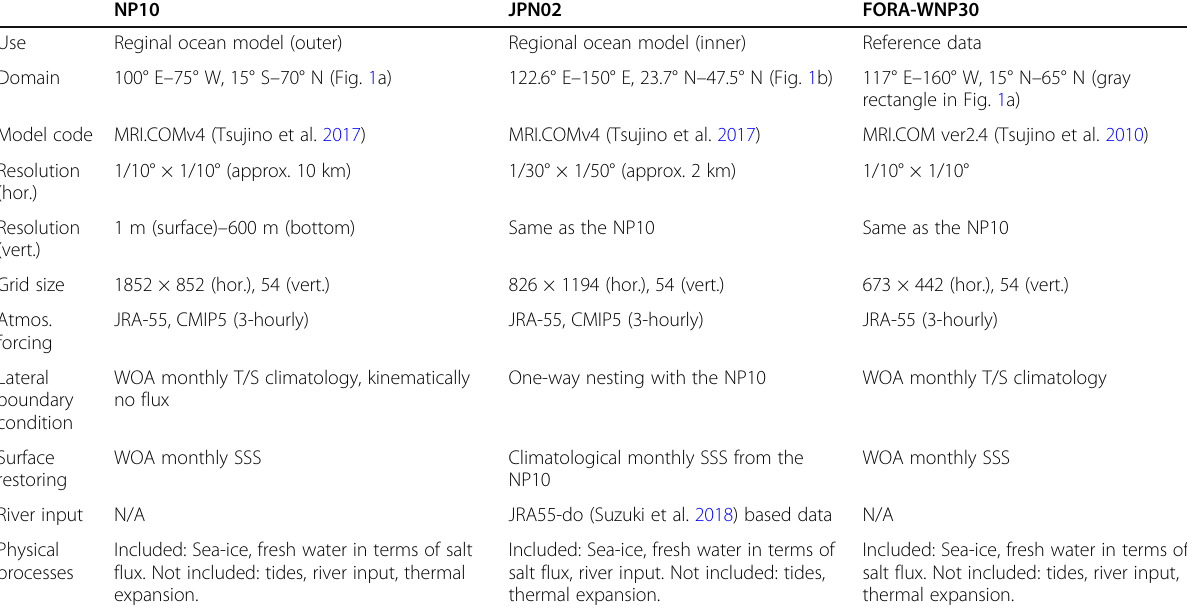
Table 1 Configurations of the regional ocean model system (NP10, JPN02) and the ocean reanalysis (FORA-WNP30, Usui et al. 2017)